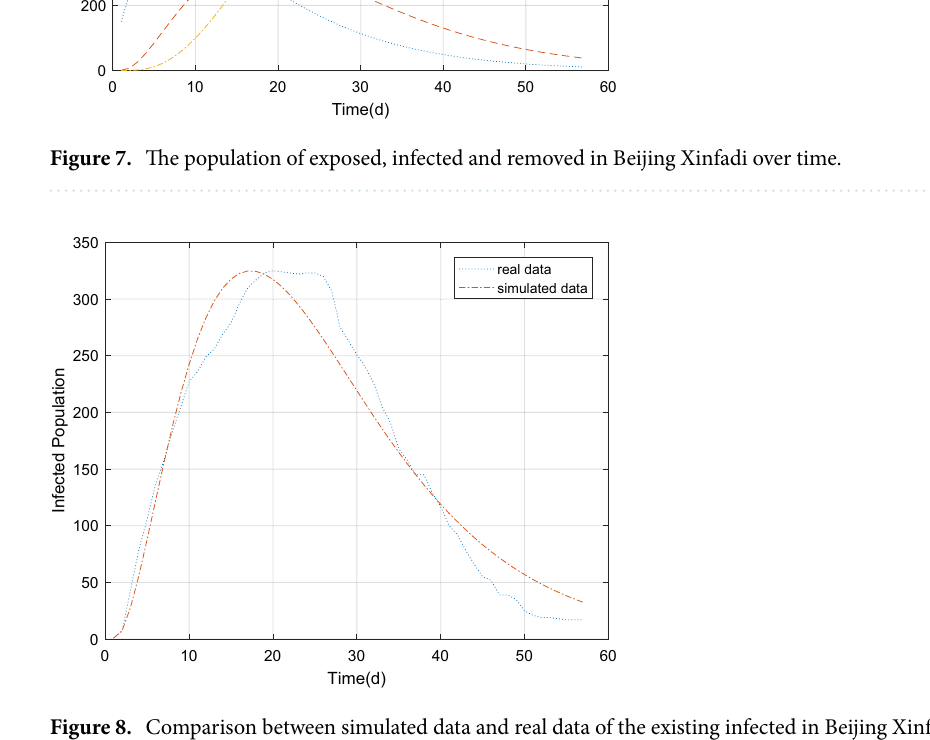
Figure 8. Comparison between simulated data and real data of the existing infected in Beijing